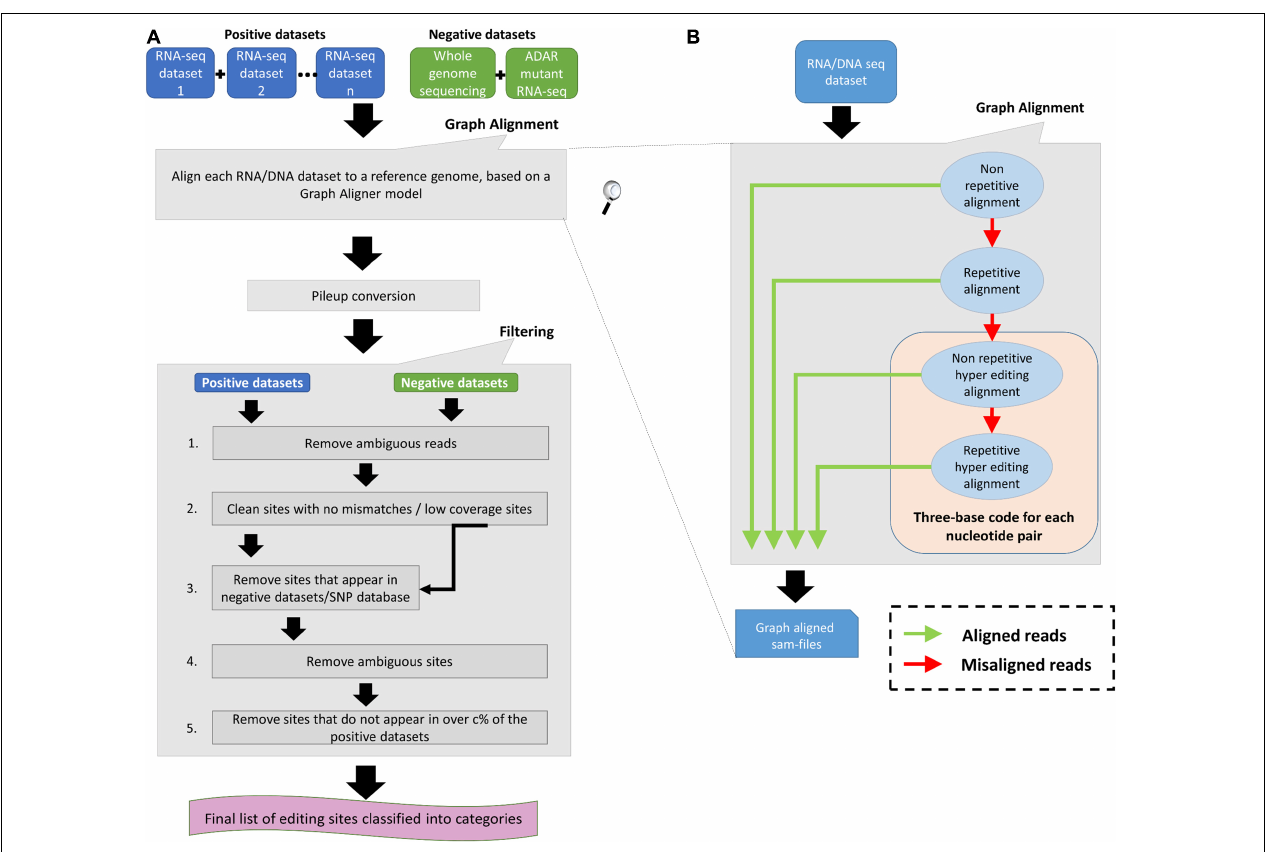
FIGURE 1 | RNA Editing Sites Identification and Classification (RESIC’s) schematic view. (A) Overall description of the RESIC pipeline. First all given sequencing datasets are filtered for ambiguous reads and go through the graph alignment scheme to detect A-to-I editing sites of different classes. The RNA-seq datasets intended for editing-sites identification are termed positive datasets, and the RNA and/or DNA sequencing datasets used to contradict editing-site existence are termed negative datasets. Sam-files for each alignment node are created using a sequence aligner (Langmead et al., 2009) and converted into pileup files using samtools (Li et al., 2009). The next stage includes several filtering steps for removing: (1) sites with no changes compared to the reference or low coverage sites; (2) SNPs or mismatches that are not originated in RNA editing, based on comparison to the negative datasets or/and a SNP database (optional); (3) sites with more than one prominent mismatch (large noise) or with low change ratio; and (4) sites that do not appear in over c% samples (optional). Finally, a list of editing sites divided into classes are given as an output with descriptive plots. (B) Zoom in on the data flow illustration of the graph aligner model for the four-layer graph used in the